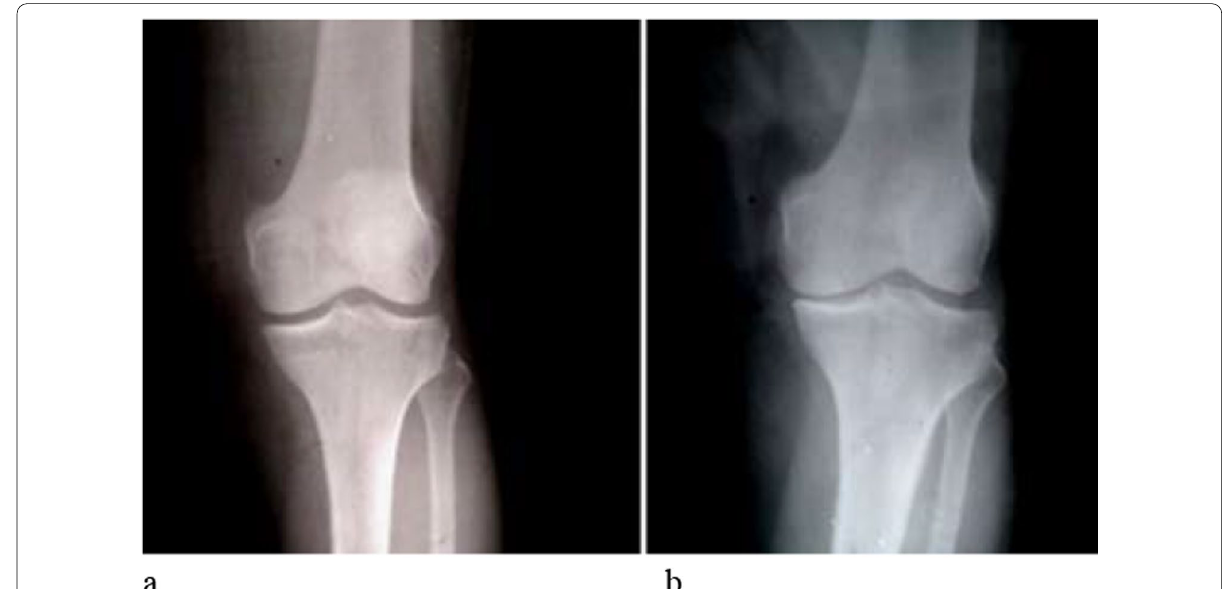
Fig. 4 A 47‑year‑old female patient, not obese (BMI 23.7 kg/m 2 ), with a history of heavy labor work presented with a sudden onset of = posteromedial left knee joint pain with a popping sound that occurred when she was doing housework for 5 months (chronic stage). At the time of injury, plain standing X‑ray of the left knee looked normal ( a ); deteriorated knee joint space narrowing 5 months later on plain X‑ray ( b ) revealed a sign of marked osteoarthritic changes in form of narrow medial joint